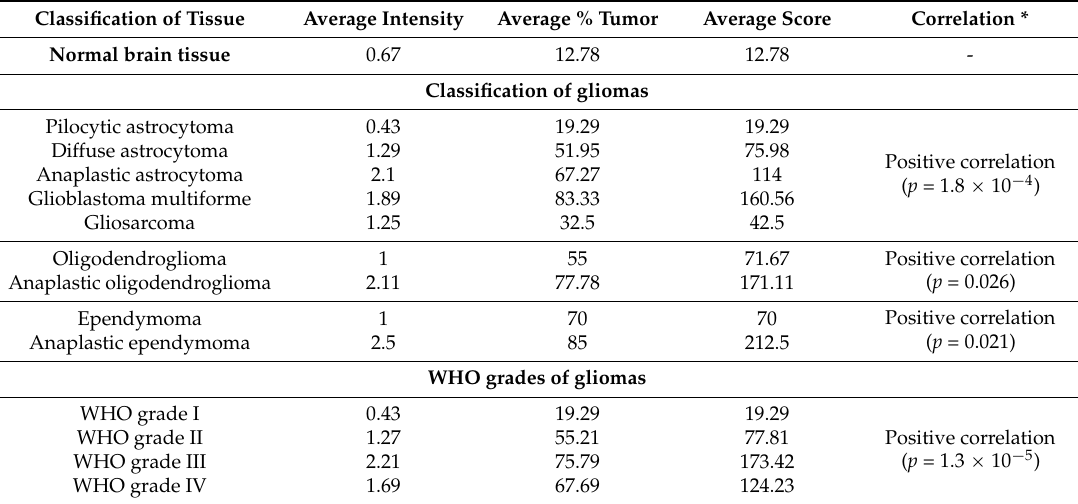
Table 2. The intensity of Nrf2 immunostaining and clinicopatholigcal parameters of gliomas. Classification of